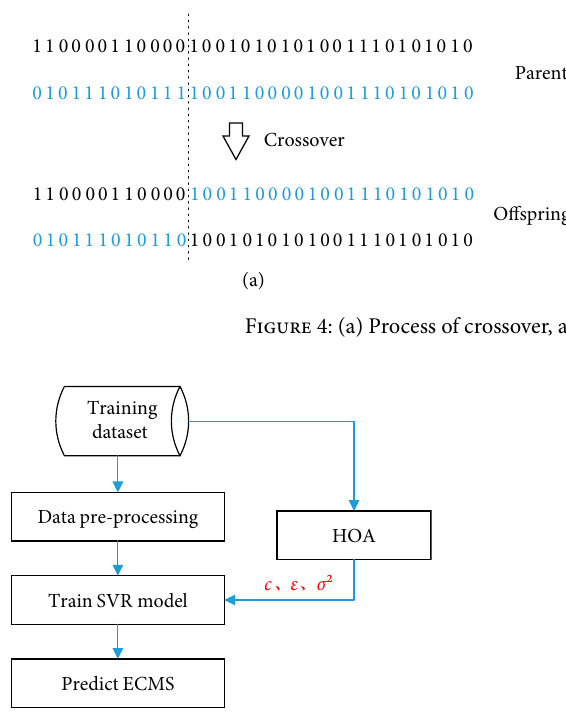
Figure 5: Process of building the SVR model to predict